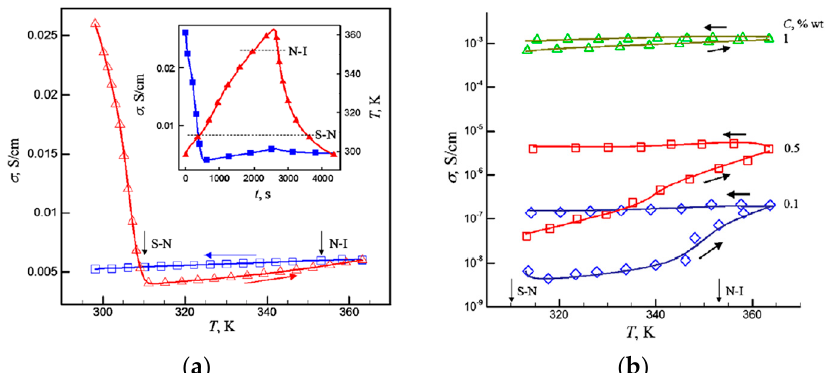
Figure 5. The electrical conductivity ( σ ) versus temperature (here, S-N = Solid-to-Nematic transition and N-I = Nematic-to-Isotropic transition); ( a ) C = 1 wt.%, f = 1 kHz, U = 1 V. The inset shows thet conductivity and temperature evolution with time t; ( b ) The hysteresis behavior of an LC-CNT composite electrical conductivity in a heating–cooling cycle at different CNT doping concentrations [39].